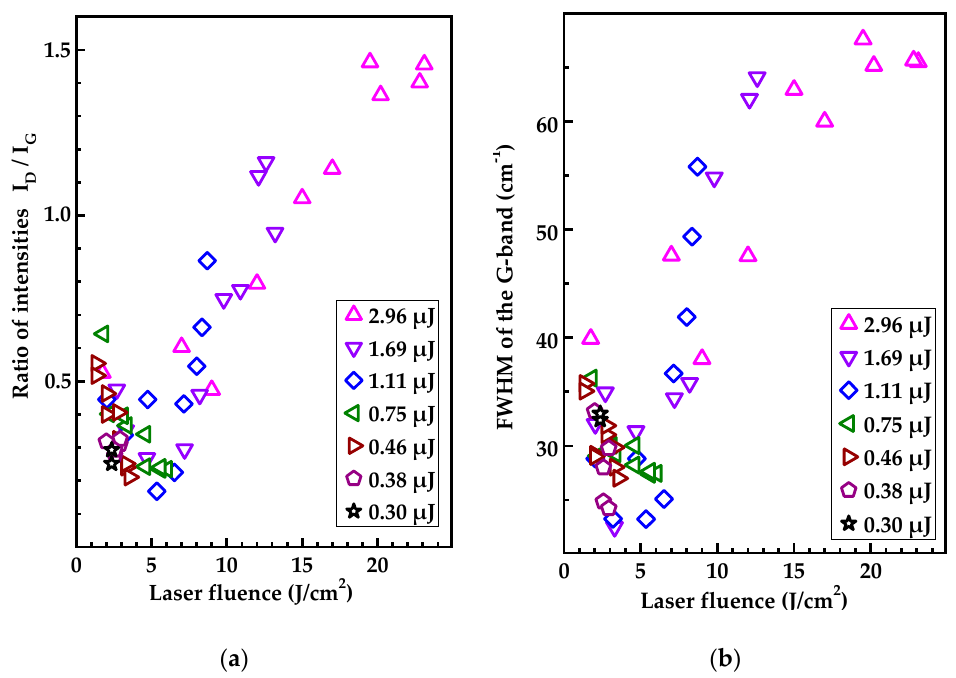
Figure 7. ( a ) The ratio between intensities of the D- and G- bands and ( b ) FWHM of the G band in the Raman spectra versus the laser fluence. Legends denote the pulse energies at which the spots explored were produced.